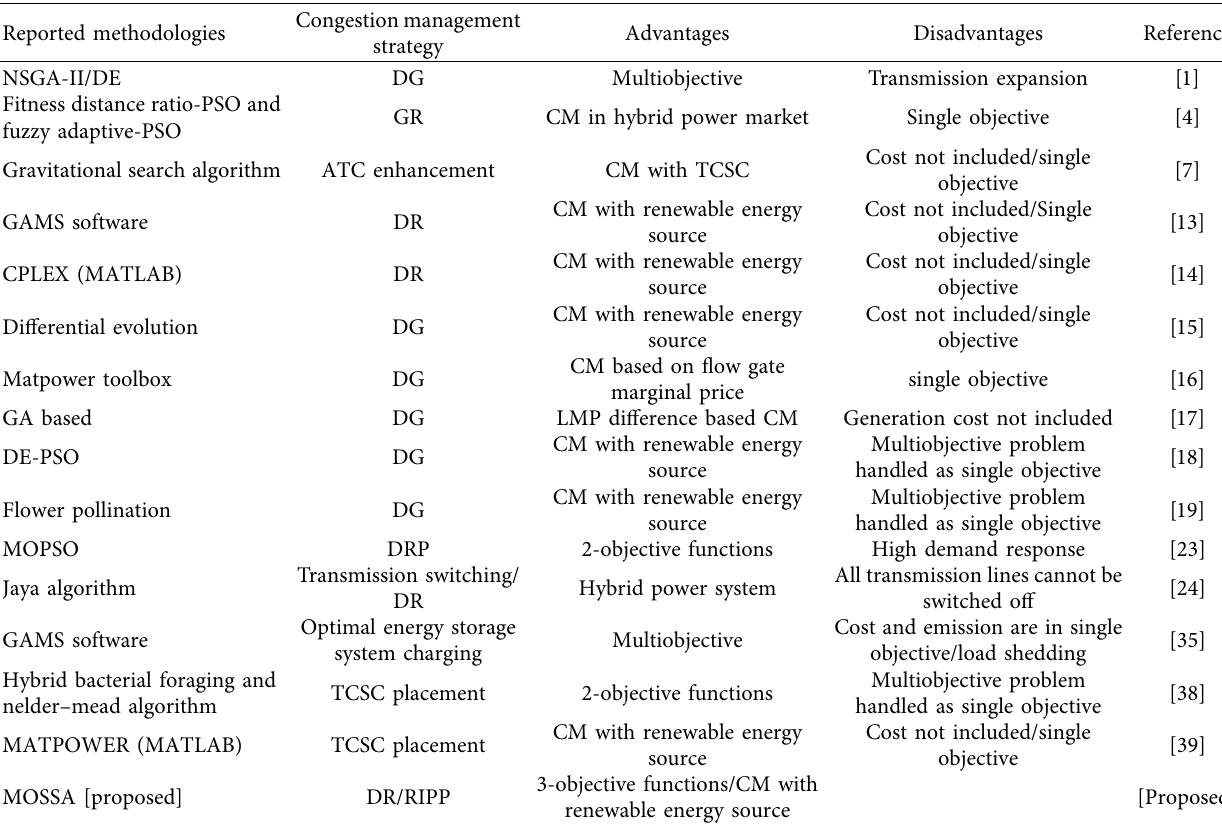
Table 1: Comparison of proposed CM approach with the reported